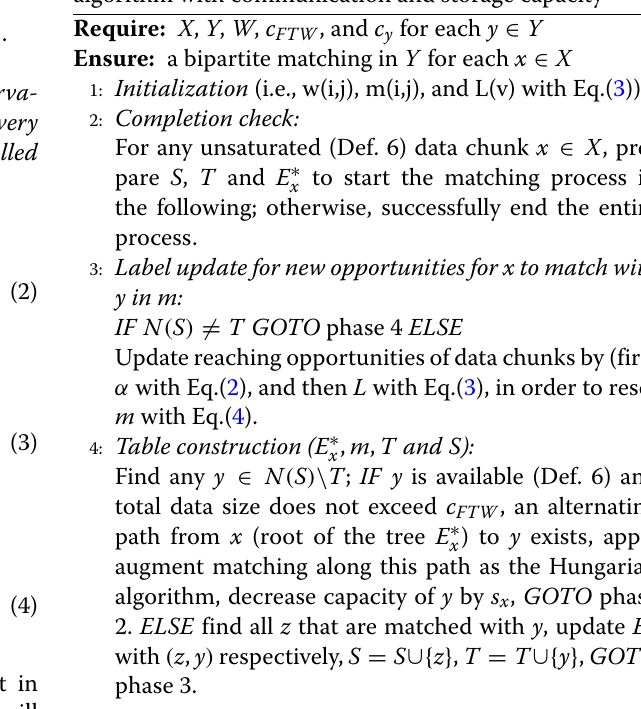
Algorithm 3 Broadcast assignment based on Hungarian algorithm with communication and storage